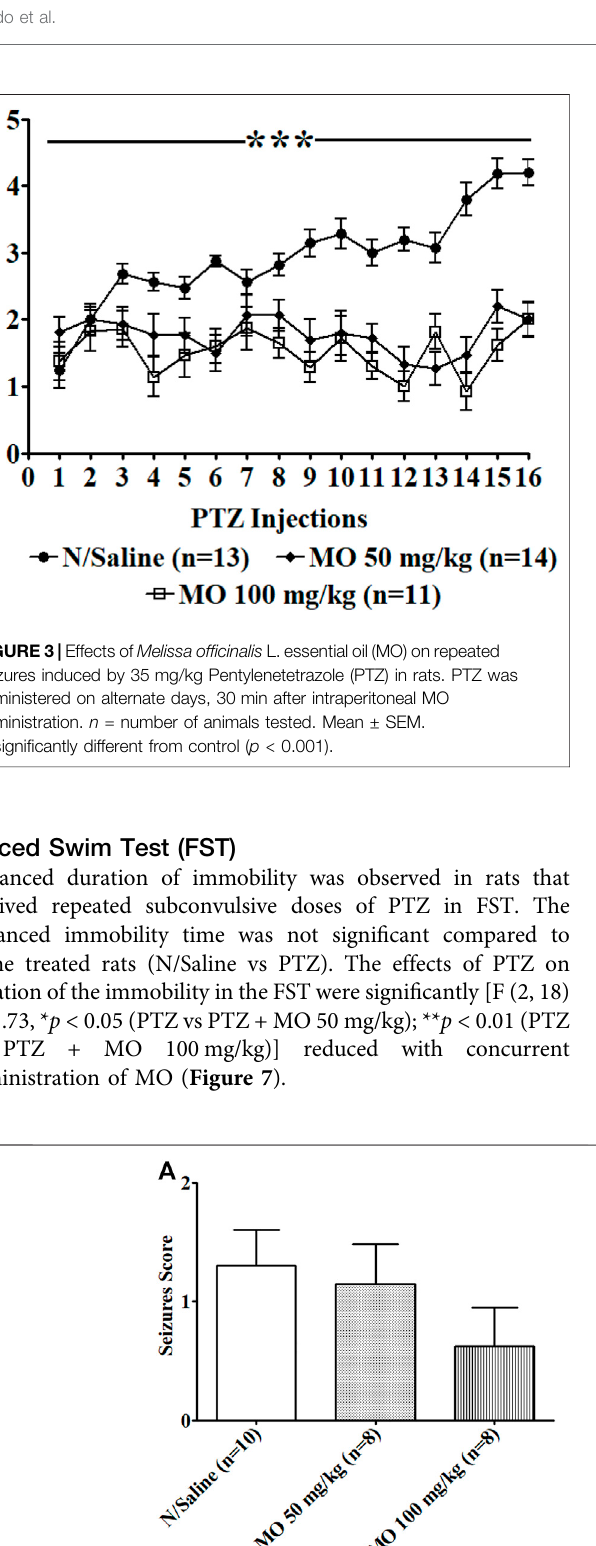
FIGURE 4 | Response of rats (control vs kindled) pretreated with either saline (sal) or Melissa of fi cinalis L. essential oil (MO) to a challenged dose of 32.5 mg/kg pentylenetetrazole(PTZ)injectedintraperitoneally,7 daysafterkindlingcompletion. (A) Controlledunkindledrats (B) Kindledrats++ p < 0.01(N/SalinevsPTZ);** p < 0.01 (PTZ vs PTZ + MO 50 mg/kg); *** p < 0.001 (PTZ vs PTZ + MO 100 mg/kg). n (cid:2) number of animals tested. Mean ± SEM.